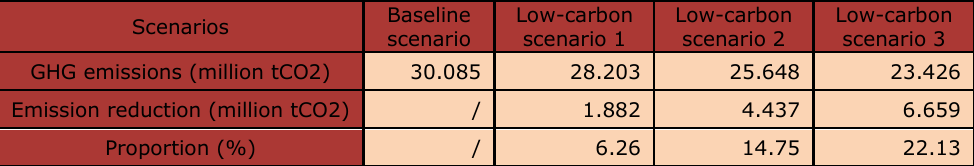
Table 2. Comparison of Scenarios 1, 2 and